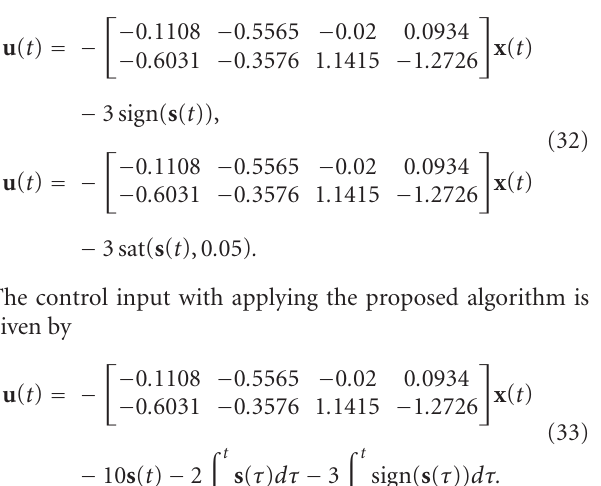
sliding mode controller and the boundary layer controller, respectively, as